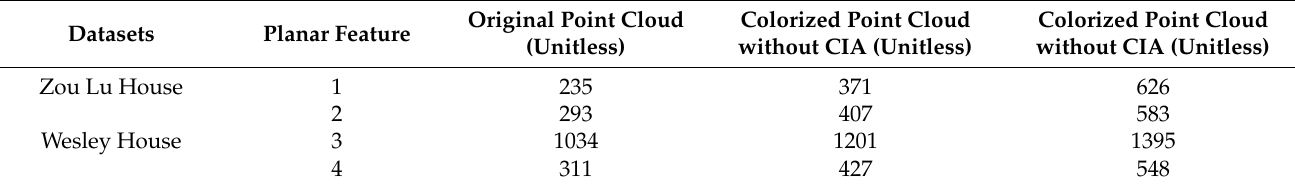
Table 3. Standard deviation of the color of the point cloud.